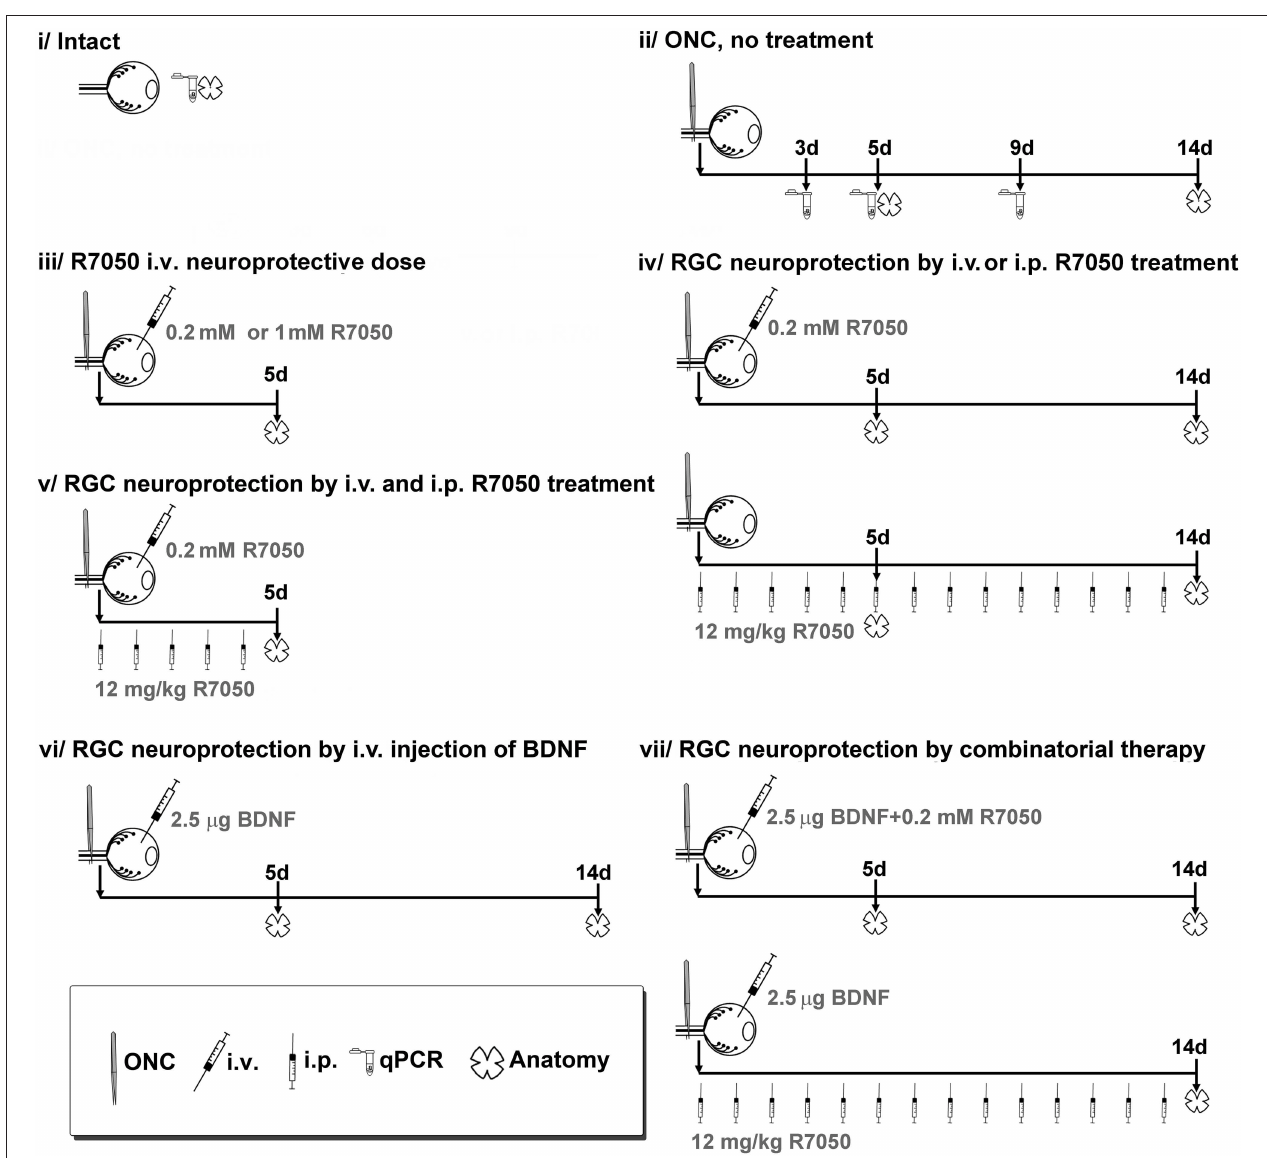
FIGURE 1 | Experimental design and animal groups. R7050 toxicity was studied at 0.2mM in intact retinas, which were analyzed 5 days after administration. As vehicle control groups, we assayed R7050 1mM vehicle (5% DMSO in saline) since it has been published that at this concentration is toxic for neurons (Galvao et al., 2014). Two groups were done, intact + i.v. of 5% DMSO and ONC + i.v. of DMSO analyzed 5 days later. To reduce the number of animals, control groups for 1% DMSO (R7050 0.2mM vehicle) were not done since in our conditions neither the population of RGCs nor their loss after axotomy was affected by an i.v. injection of 5% DMSO. Likewise, intraperitoneal vehicle of R7050 and intravitreal vehicle of BDNF groups were not done because we have already shown that those vehicle formulations and administration routes do not have a negative effect in the retina (Galindo-Romero et al., 2013b; Di Pierdomenico et al., 2018). i.v, intravitreal